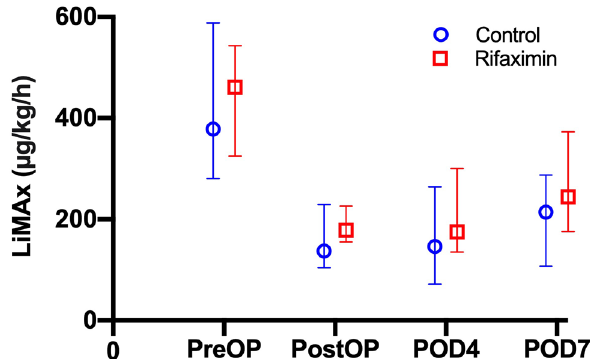
Figure 3. Course of liver function with respect to trial group. Liver function assessed with LiMAx during the trial period is presented as median and interquartile range. Liver function was significantly reduced due to liver resection and did subsequently recover in the postoperative period. However, no time point showed statistical significance between the Rifaximin and control group (preOP: p = 0.567; postOP: p = 0.125; POD 4: p = 0.142; POD 7: p = 0.483). LiMAx, maximum liver function capacity; POD, postoperative day; postOP, after surgery; preOP, prior to surgery.